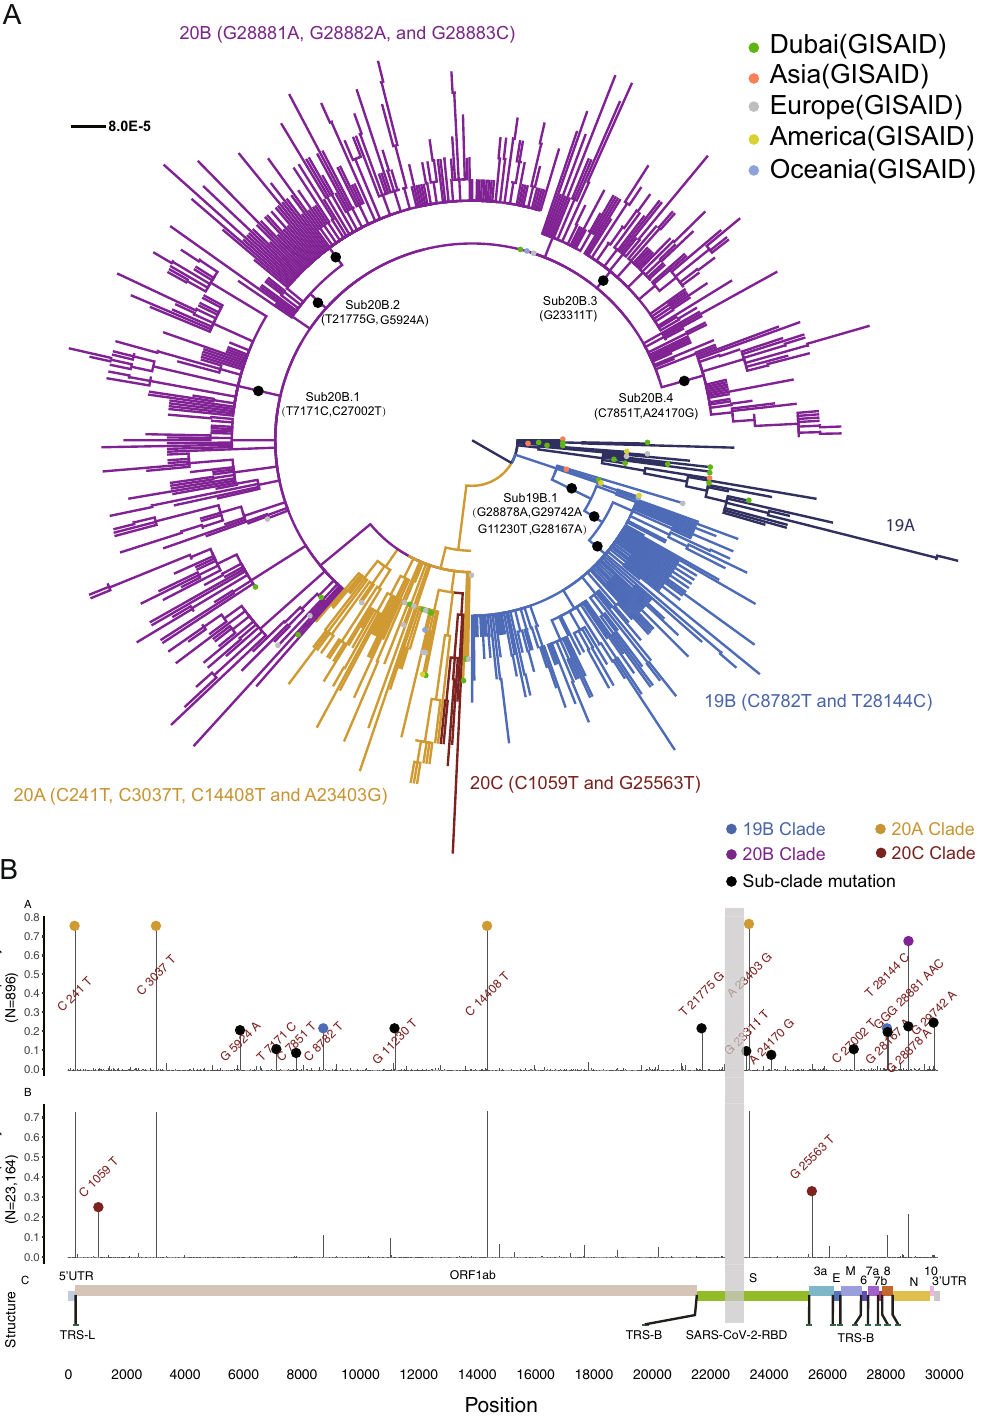
Figure 2. Phylogenetic analysis of the sequenced UAE viral population during May and June. ( A ) Maximum likelihood tree of the 637 unique viral genomes with less than 2% gaps and 52 closest relatives from GISAID. Each line indicates a sample colored by the five dominant viral clades worldwide (19A: MidnightBlue, 19B: RoyalBlue, 20A: GoldEnrod, 20B: Purple, 20C: SaddleBrown), annotated with the clade definitive genetic variation. The closest relatives from GISAID were marked by a dot colored by geographical district reported for the viral sample. The subclade-definitive genetic variations were marked in black. ( B ) Comparison of the alternative allele frequency of the 1245 viral genetic variants between the 896 high quality UAE viral genomes and the 23,164 viral genomes from the globe downloaded from the China National Center for Bioinformation. Nomenclature of the clades was detailed in “Supplementary